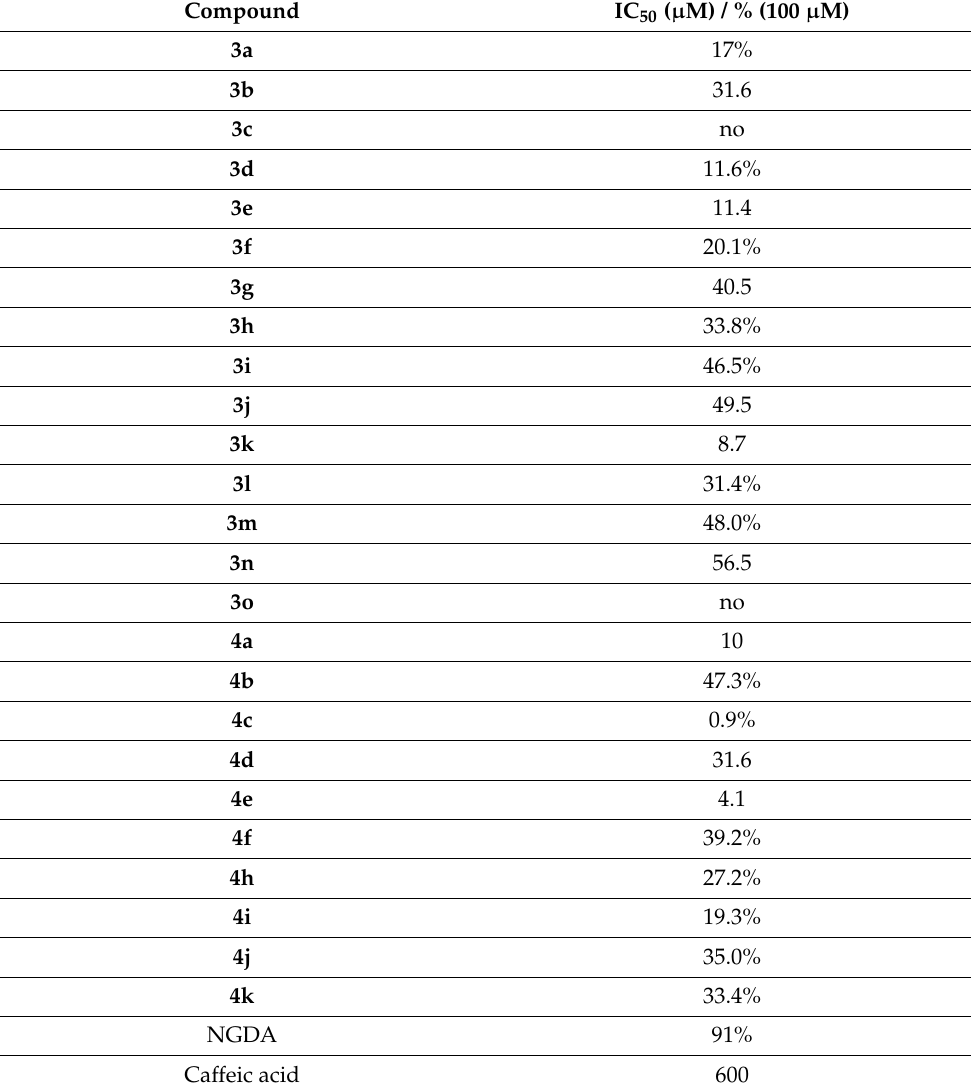
Table 3. Soybean LOX in vitro inhibitory activity of the synthesized coumarin derivatives * ,#,$